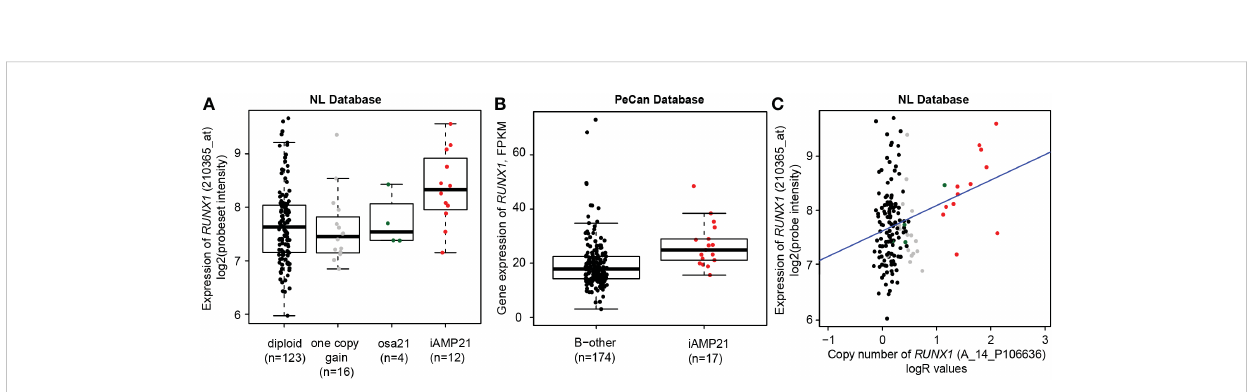
FIGURE 3 RUNX1 copy number and expression in iAMP21 cases. (A) Expression levels of RUNX1 (log2 intensities) categorized based on chromosome 21 copy number aberrations determined by aCGH: diploid, one copy gain, other structural aberration on chromosome 21 (osa21), and iAMP21. (B) Expression of RUNX1 (FPKM) in the PeCan database. Selected cases were categorized based on iAMP21 status, as described in the PeCan database. (C) Correlation between copy number (normalized LogR values, x-axis) and gene expression (log2 values, y-axis). Cases are coloured based on chromosome 21 copy number aberrations determined by aCGH: diploid, one copy gain, other structural aberration on chromosome 21 (osa21), and iAMP21 (see fi gure 3A). Blue line represents the linear regression trendline using all samples shown in this fi gure.